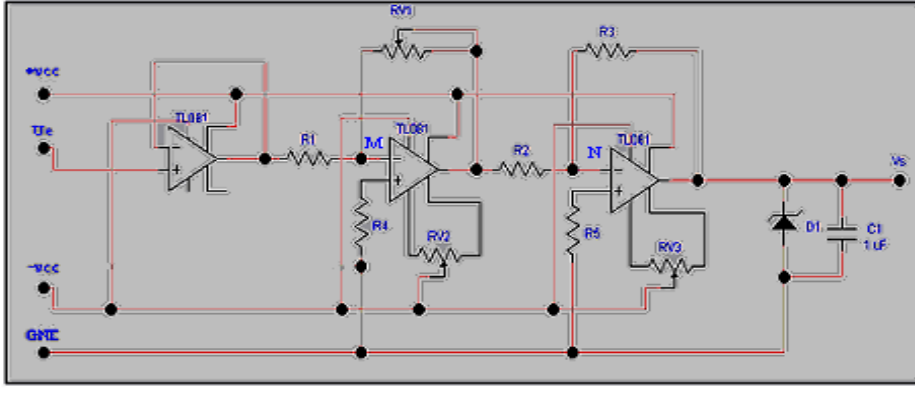
Figure 14. Voltage divider connected to a precision instrumentation amplifier.